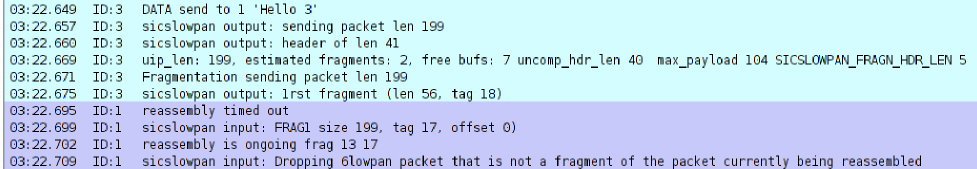
Figure 12. Log listener—normal packet fragmentation.